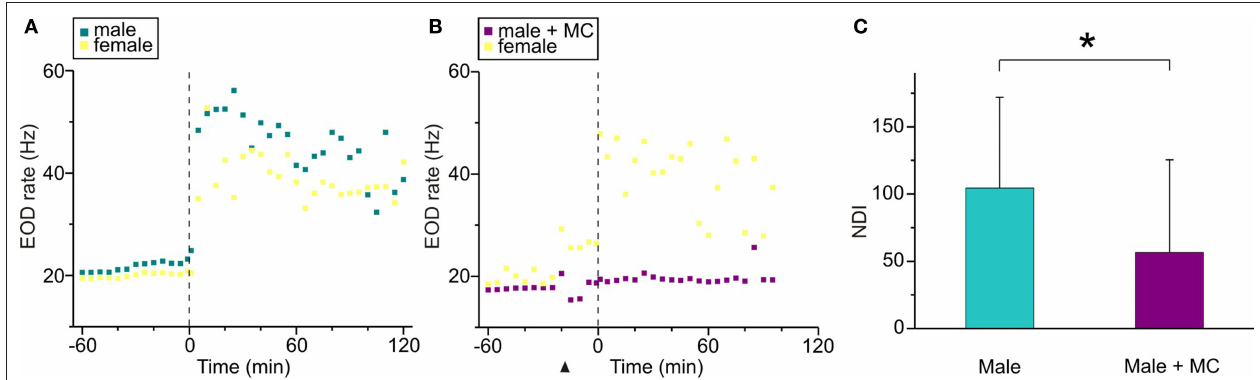
sunset (arrowhead) and no increase of EOD rate was observed during the night, whereas the female exhibited a nocturnal increase of its EOD rate similar to the